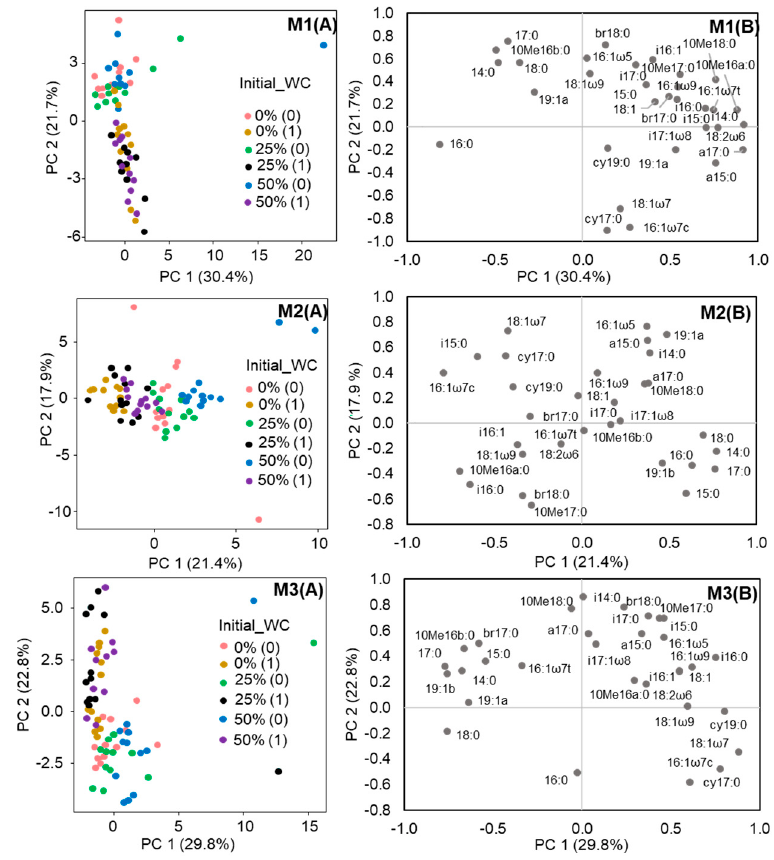
Figure 2. Score ( A ) and loading plots ( B ) from principal component analysis of the PLFA data of the di ff erent soil mixtures separately: M1 (Soil mixture 1), M2 (Soil mixture 2), M3 (Soil mixture3). Soils with 0%, 25% and 50% initial water content and analysed immediately after heating (0) and after one month of incubation (1).